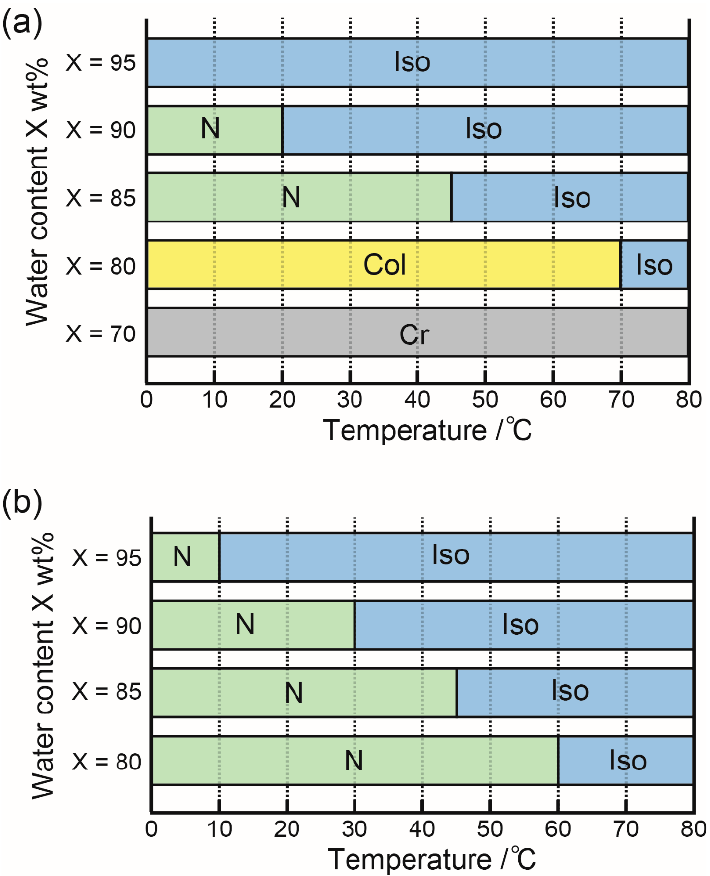
Figure 11. Bar graphs of the thermotropic phase transition behavior of; ( a ) the pQpdS-Li/ H 2 O mixtures on cooling; ( b ) the pQpdS-Na /H 2 O mixtures on cooling.